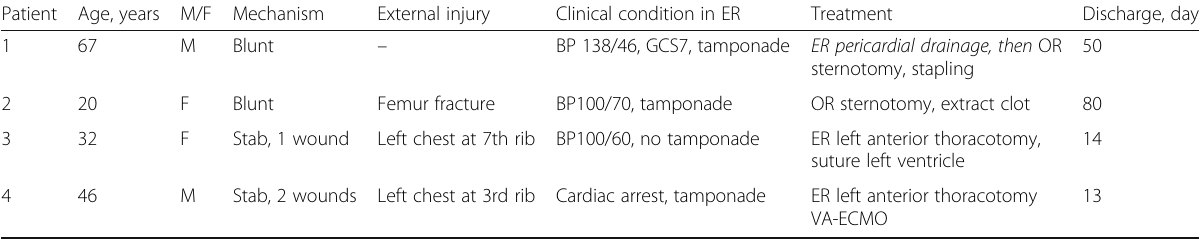
Table 1 Clinical characteristics of 4 patients who survived traumatic cardiac injuries Patient Age, years M/F Mechanism External injury Clinical condition in ER